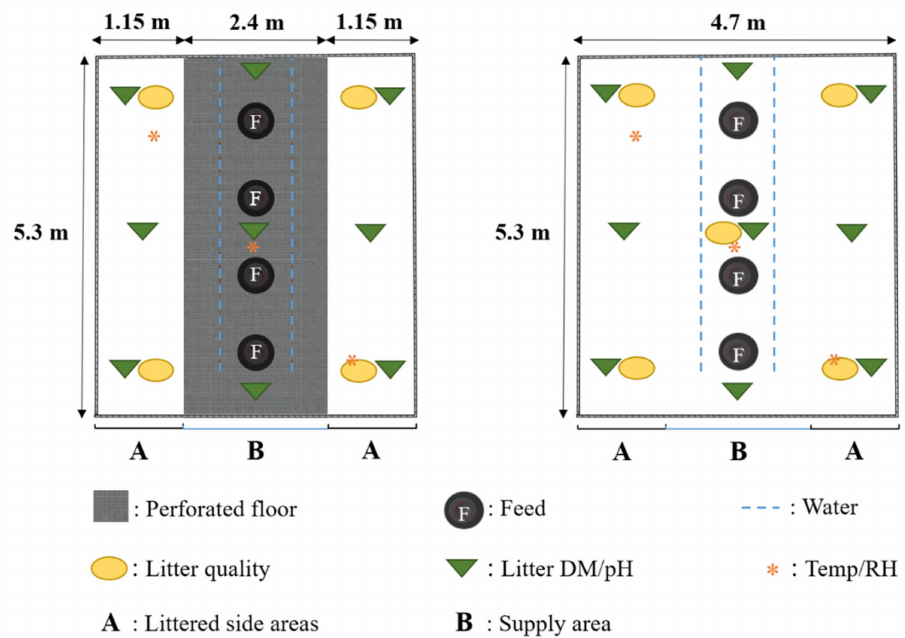
Figure 2. Floor plan view of the partially perforated flooring system, with an elevated perforated area in the section of feed and water supply, and the littered flooring system, including measurement positions for litter quality, litter dry matter (DM), litter pH (pH), air temperature (Temp), and relative air humidity